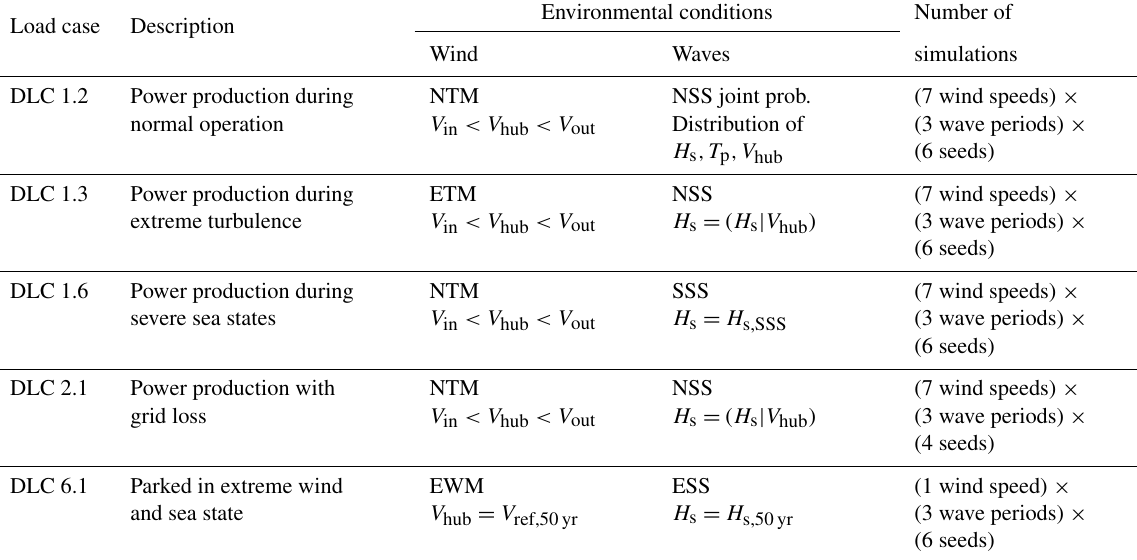
Table 3. Selection of design load cases. Note that the comparative study was limited to aligned wind–wave conditions only, due to the restriction of QuLAF to planar motion. Each simulation had a length of 90min, where the first 30min were discarded to remove transient response in the time-domain